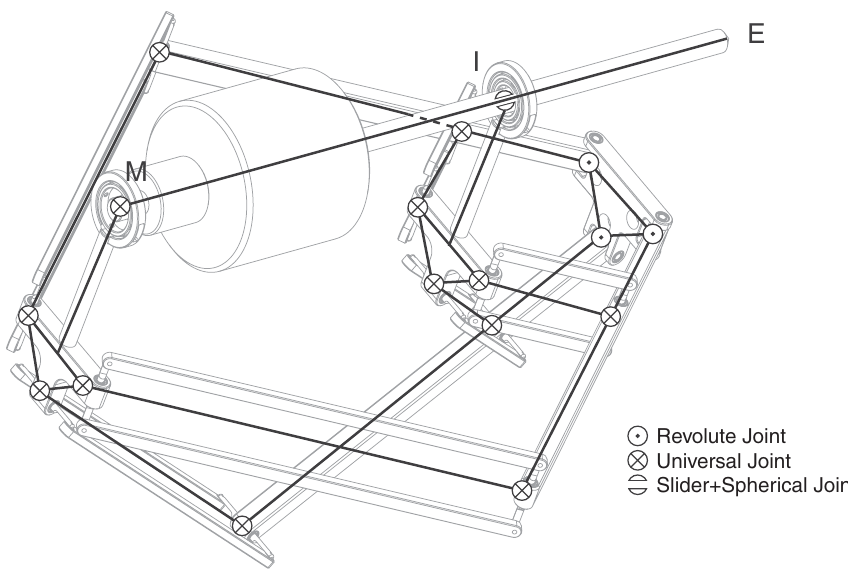
Fig. 10. Kinematic structure of Dionis